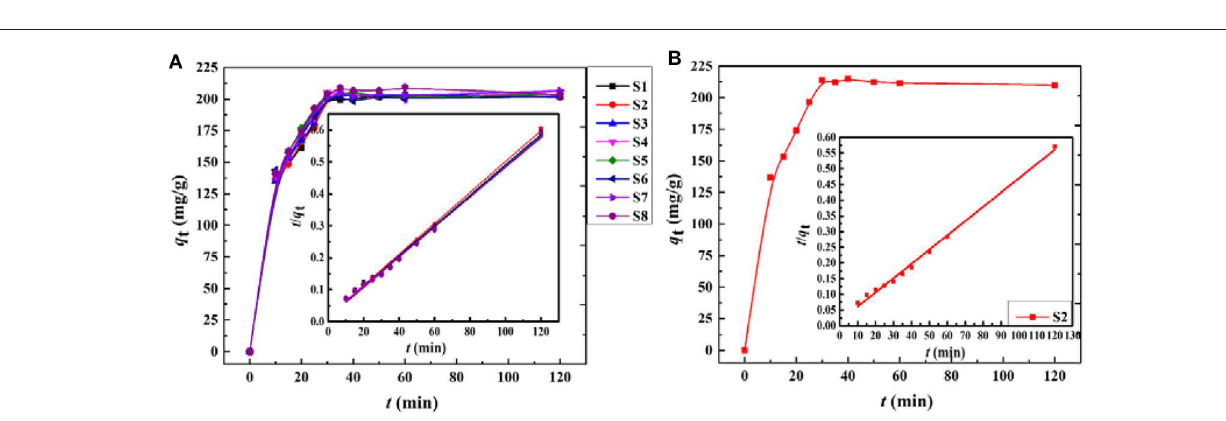
FIGURE 8 | Adsorption kinetics curves of the porous CMC- g -PAM/ATP materials for (A) Ce(III) and (B) Gd(III) (inset plot of t / q t vs. t for the pseudo-second-order